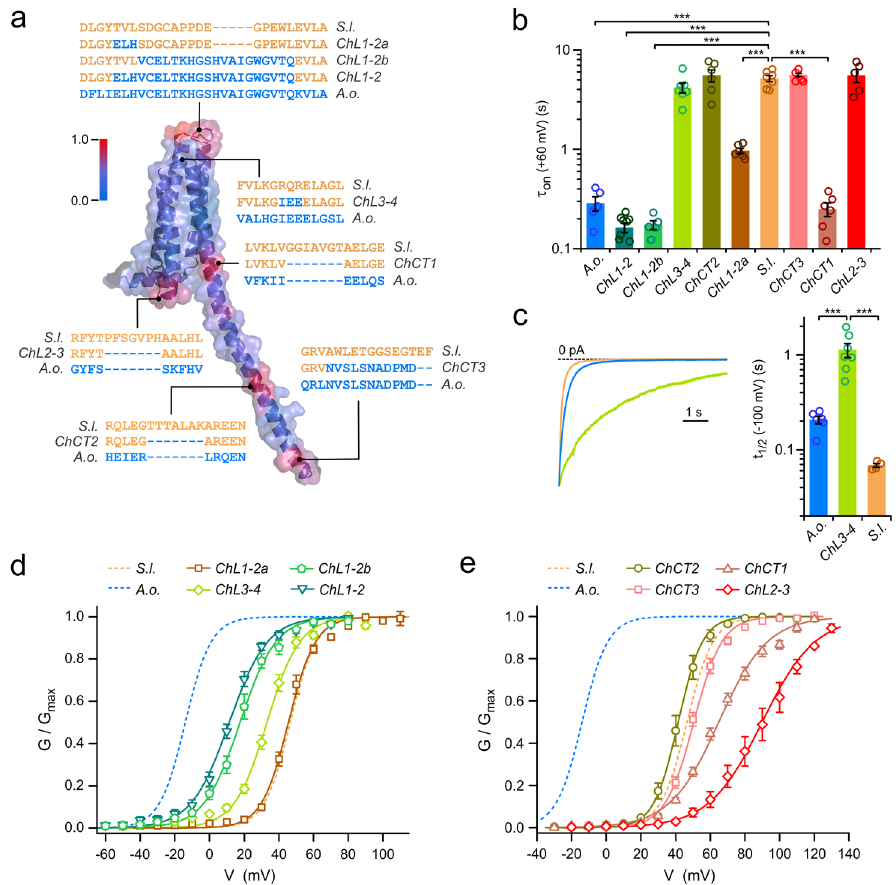
on crystal structures 3WKV and 3VMX. Color of surface and cartoon representations indicates divergence in sequence homology between SlHv1 and AoHv1. Gradient varies from minimal divergence (blue) to maximal divergence (red) (see “ Methods ” for details). Swapped sequences in the eight